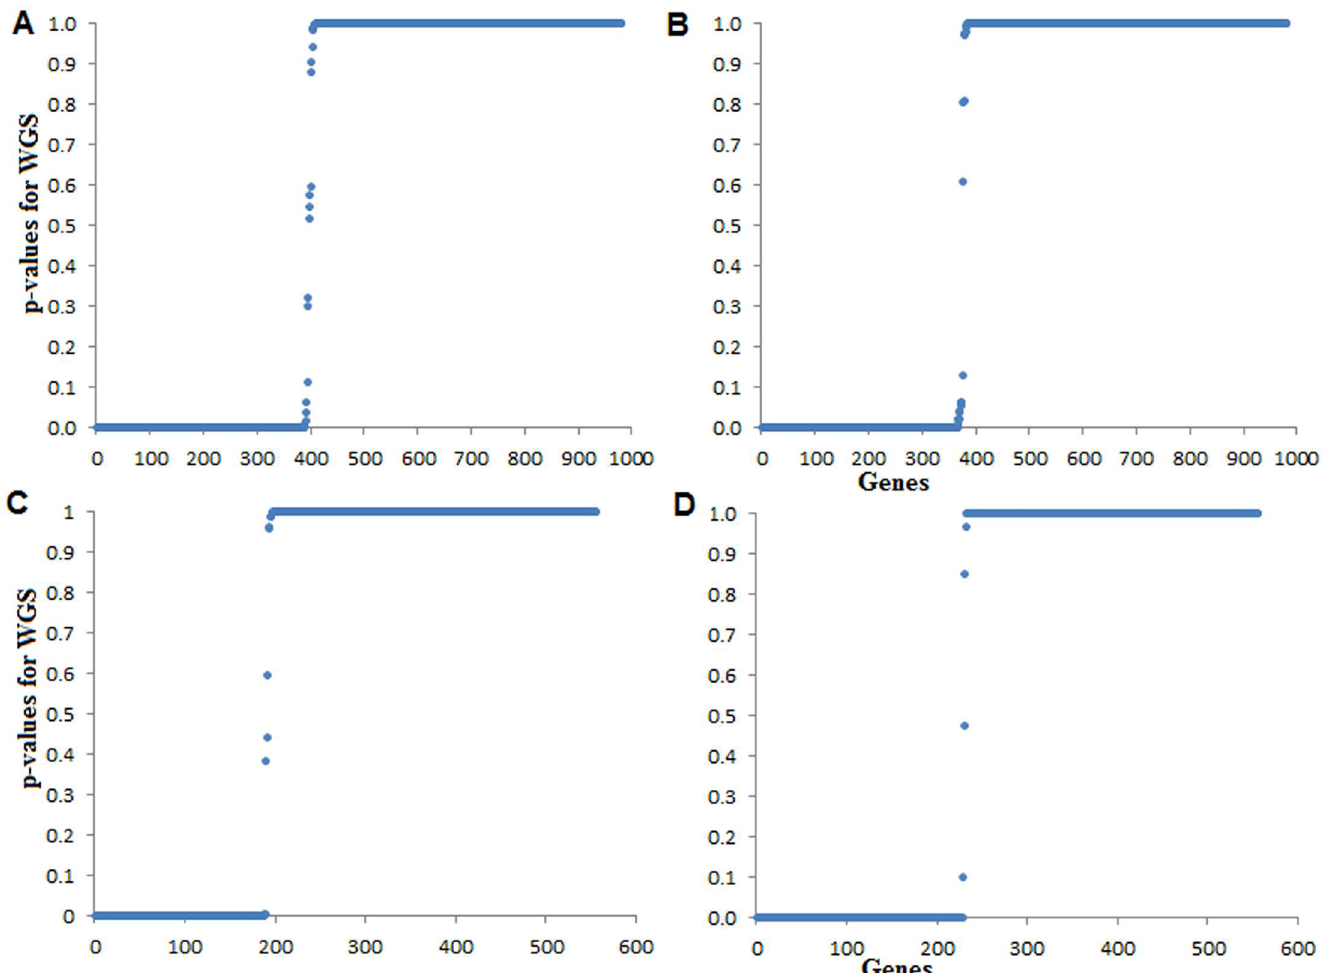
Fig 6. Distribution of p-values under stress and control conditions. The distributionsof p-values of genes in GCNs for Al stress (A) and control (B) conditionsin soybeanare shown. The distributionsof p-values of genes in GCNs for salinity stress (C) and control (D) conditions in rice are shown. Genes with low p-values represent highly interacting genes in the GCN.